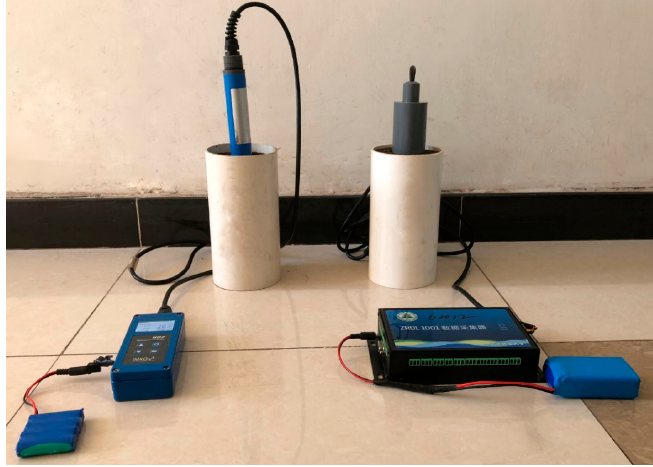
Figure 3. Photograph of the experimental setup for water content measurement by TDR and SWR.